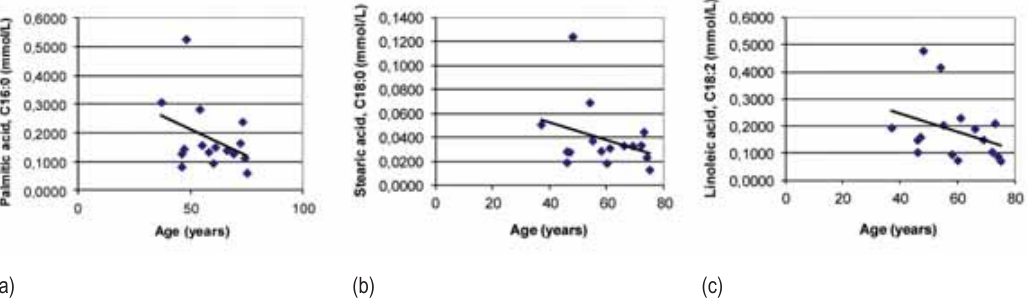
FIGURE 5. The correlation between age and plasma levels of palmitic acid (a), stearic acid (b), linoleic acid (c) in male patients with Type 2 diabetes mellitus. Spearman´s correlation coef fi cients ρ = -0.100, ρ = -0.204, and ρ = -0.178,